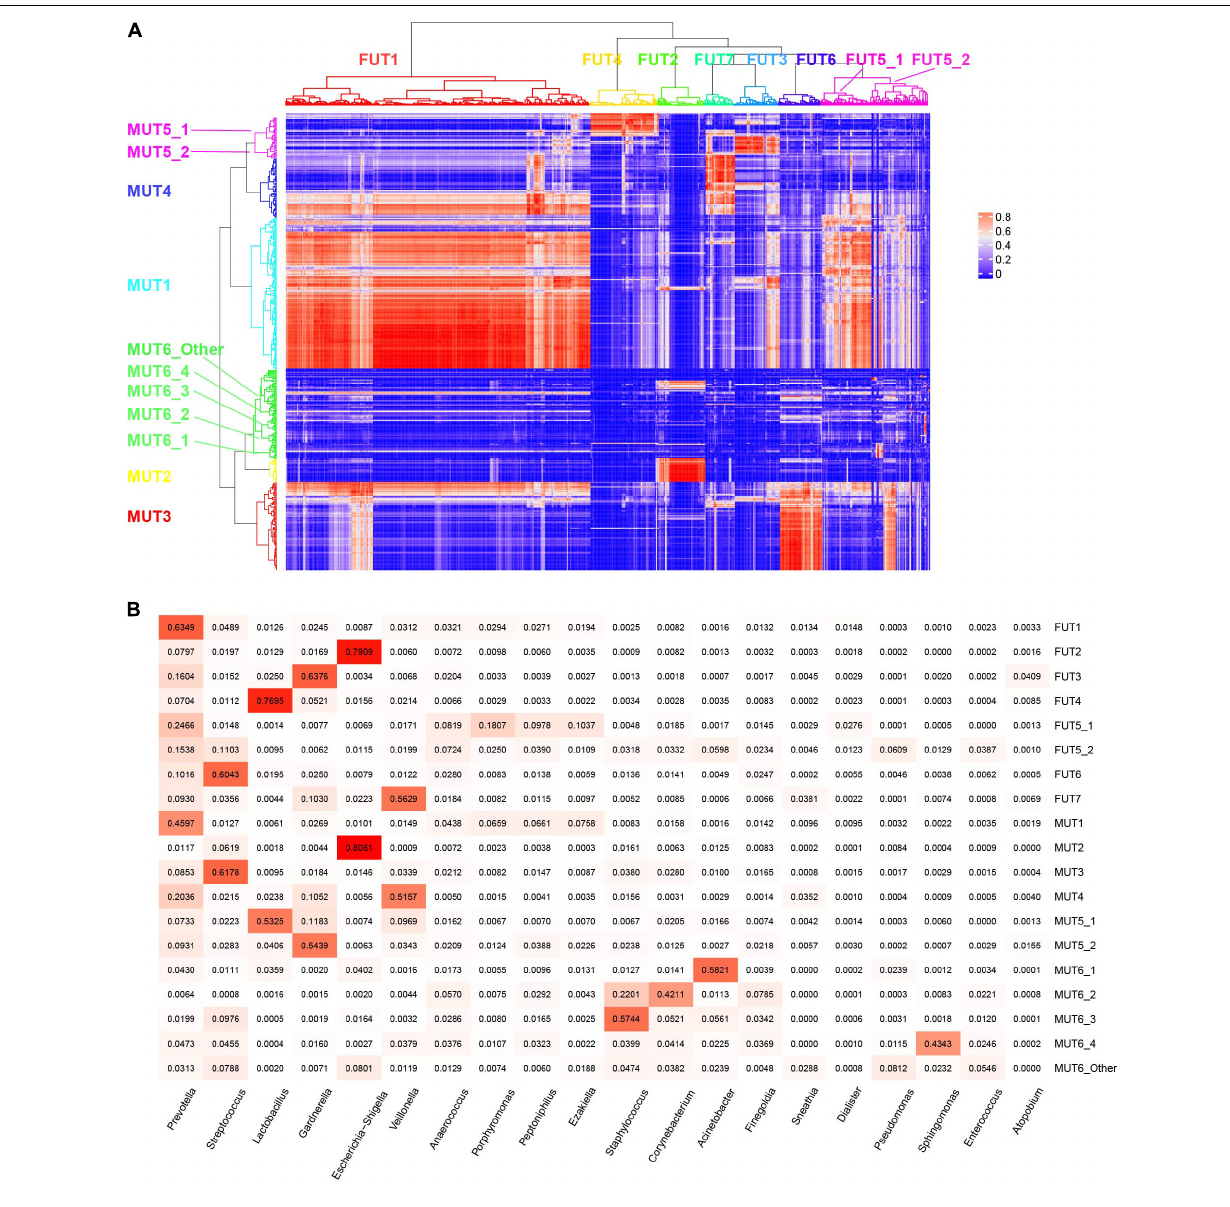
depth and sample size, we classified all samples into